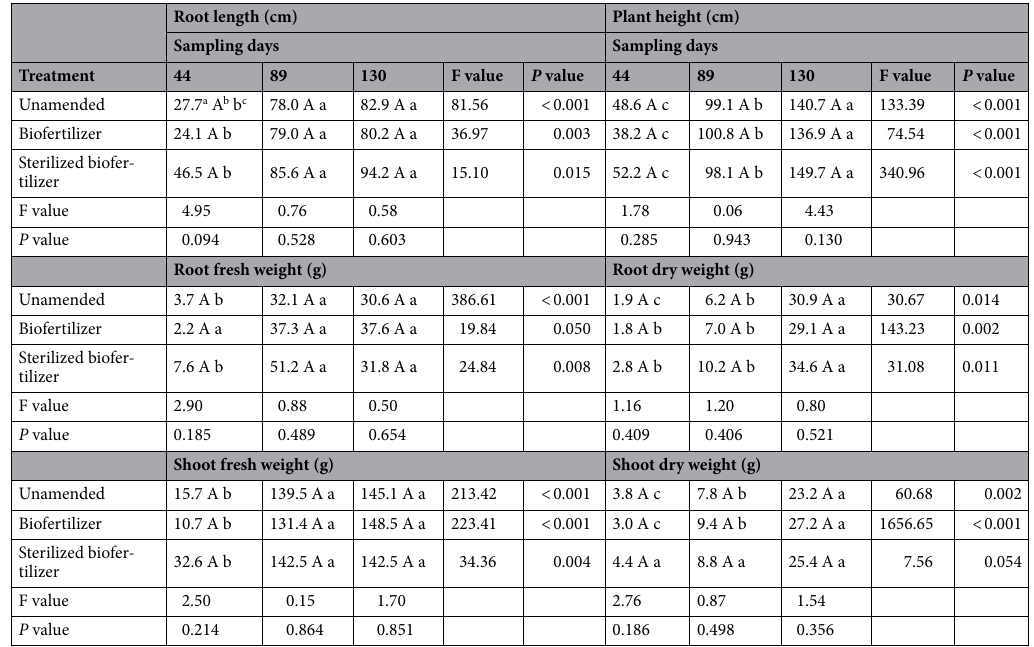
Table 1. Characteristics of maize plants ( Zea mays L.) in soil left unamended, amended with biofertilizer or sterilized biofertilizer after 44, 89 and 130 days. a Mean of three samples, b values with the same capital letter are not significantly different between the treatments, i.e. within the columns, c values with the same letter are not significantly different over time, i.e. within the rows. A non-parametric test was used, i.e. t1way test of the WRS2 package, to test the effect of time and treatment (a collection of robust statistical methods 51